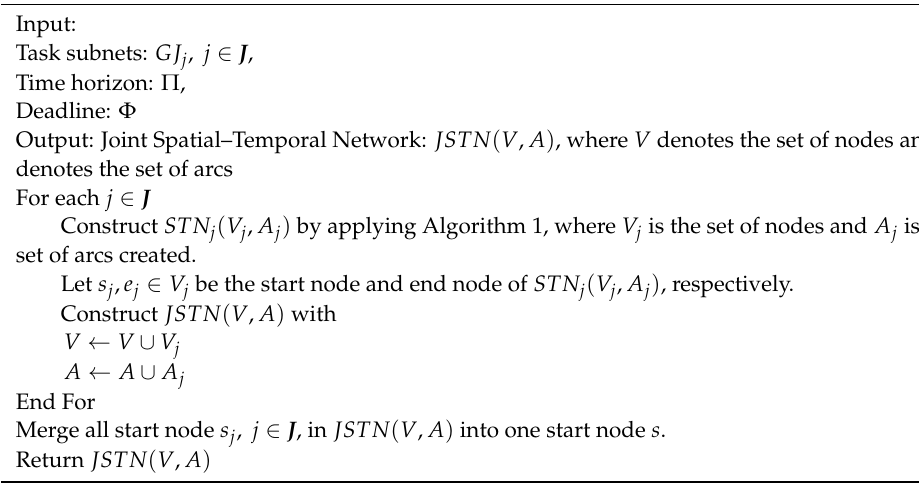
Figure 5. A Joint Spatial–Temporal Network (JSTN). Algorithm 2: Joint Spatial–Temporal Network Construction